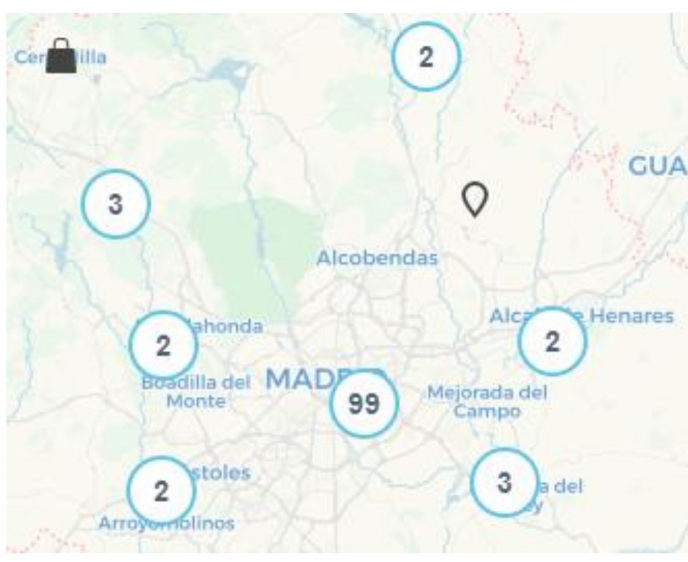
Figure 4. Madrid region map of businesses which accept Bitcoin. Source: